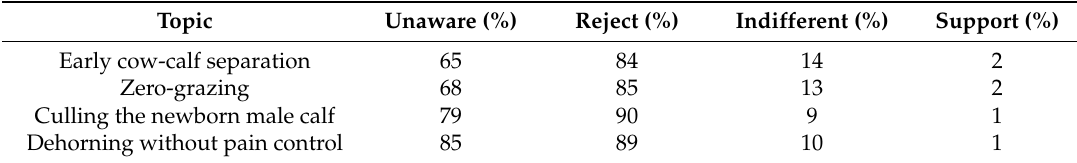
Table 3. The percentage of participants ( n = 296) who were unaware, and who then either rejected, were indifferent or supported early cow-calf separation, zero-grazing systems for dairy cows, culling the newborn male calf, or disbudding/dehorning calves without pain control once they were informed about the